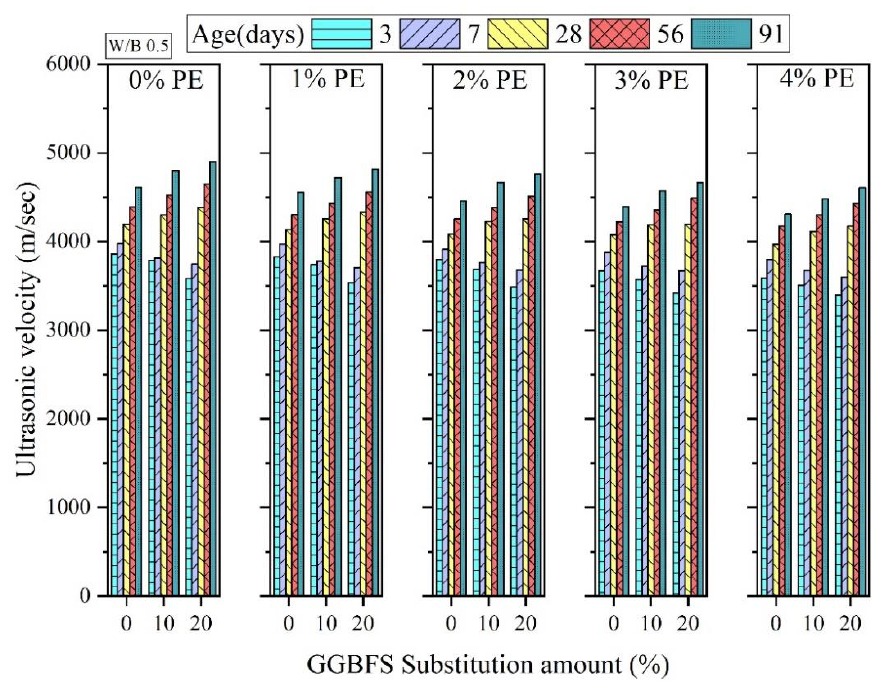
Figure 9. The ultrasonic velocity of cement mortars with the addition of different ratios of waste PE and GGBFS and GGBFS replacement.